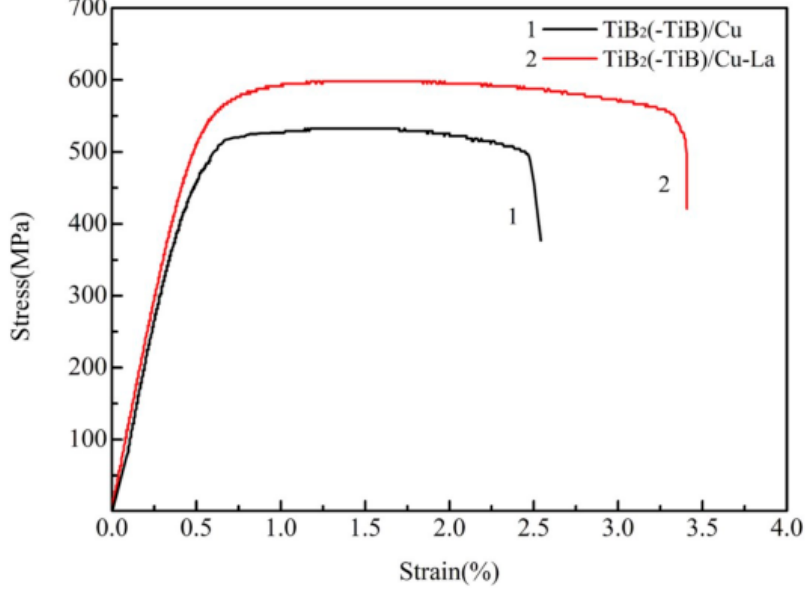
Figure 19. Tensile stress–strain curves of rolled TiB 2p (–TiB w )/Cu and TiB 2p (–TiB w )/Cu–La composites [23]. Reprinted/adapted with permission from Ref. [23]. Copyright year 2020, Elsevier.